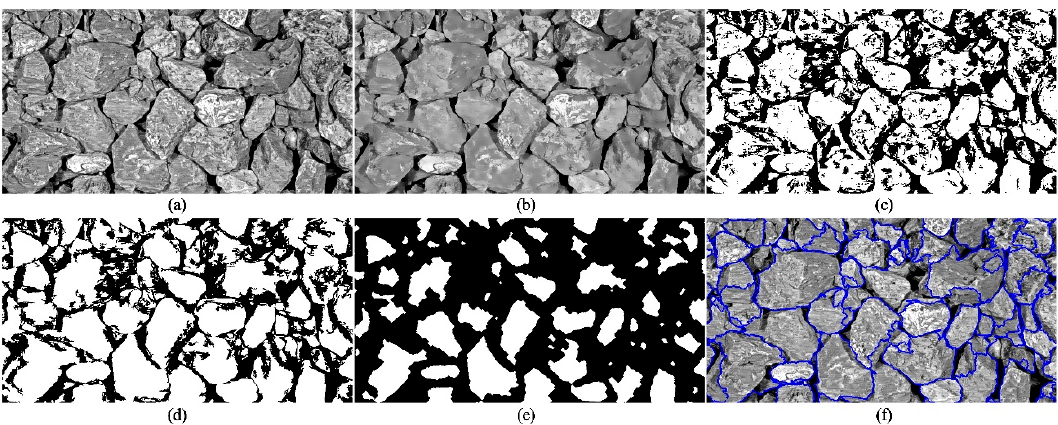
Figure 6. Original ( a ), after the first step ( b ), after the second step ( c ), after the third step ( d ), after the fourth step ( e ), and after the fifth step ( f ).